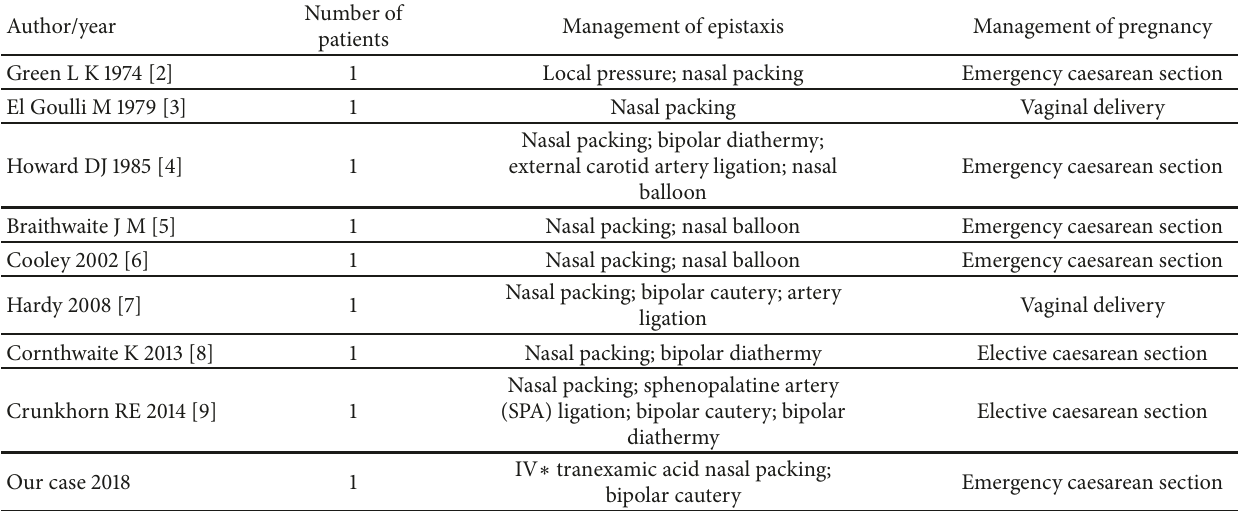
Table 1: Cases of severe epistaxis during pregnancy not associated with nasal lesion or clotting